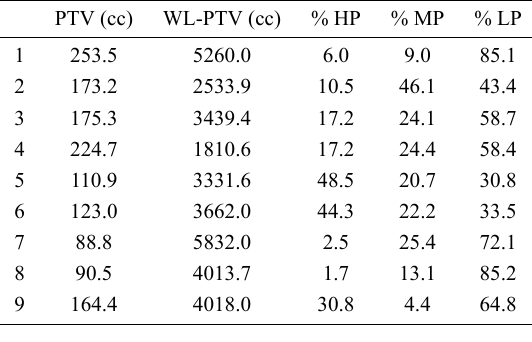
Table 2. Patients’ clinical characteristics.